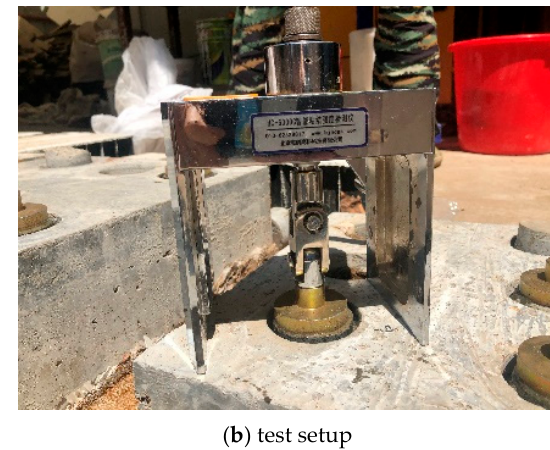
Figure 3. Layout the pull-off test (unit: mm).